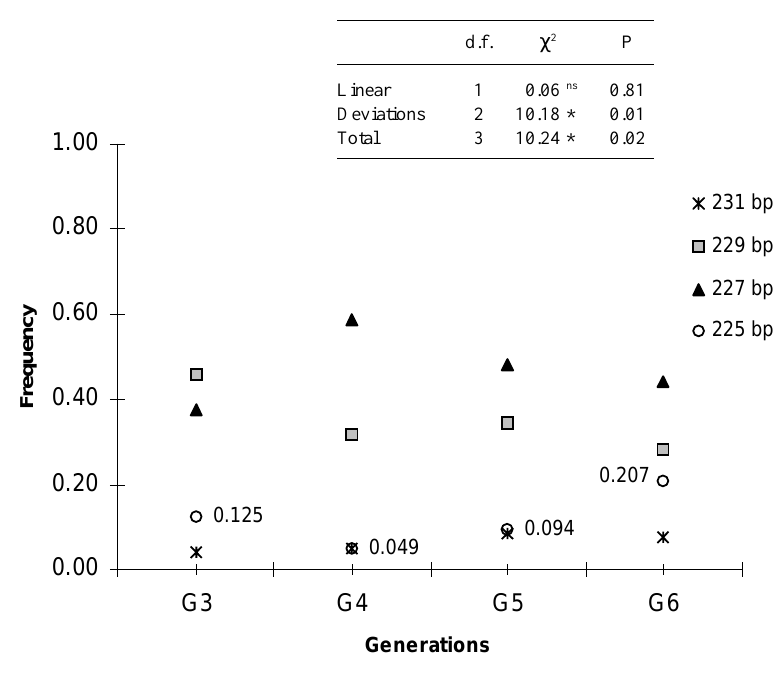
Figure 2 - Frequency variation of microsatellite IGF-I alleles over different generations of Canchim cattle. Results of chi- square analysis are shown on the top right of the figure. ns and *: Nonsignificant and significant at P < 0.05, respectively.